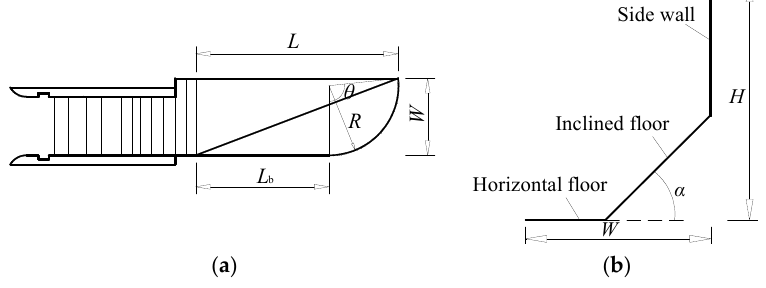
Figure 3. Sketch with relevant parameters: ( a ) plan view; ( b ) sectional view.